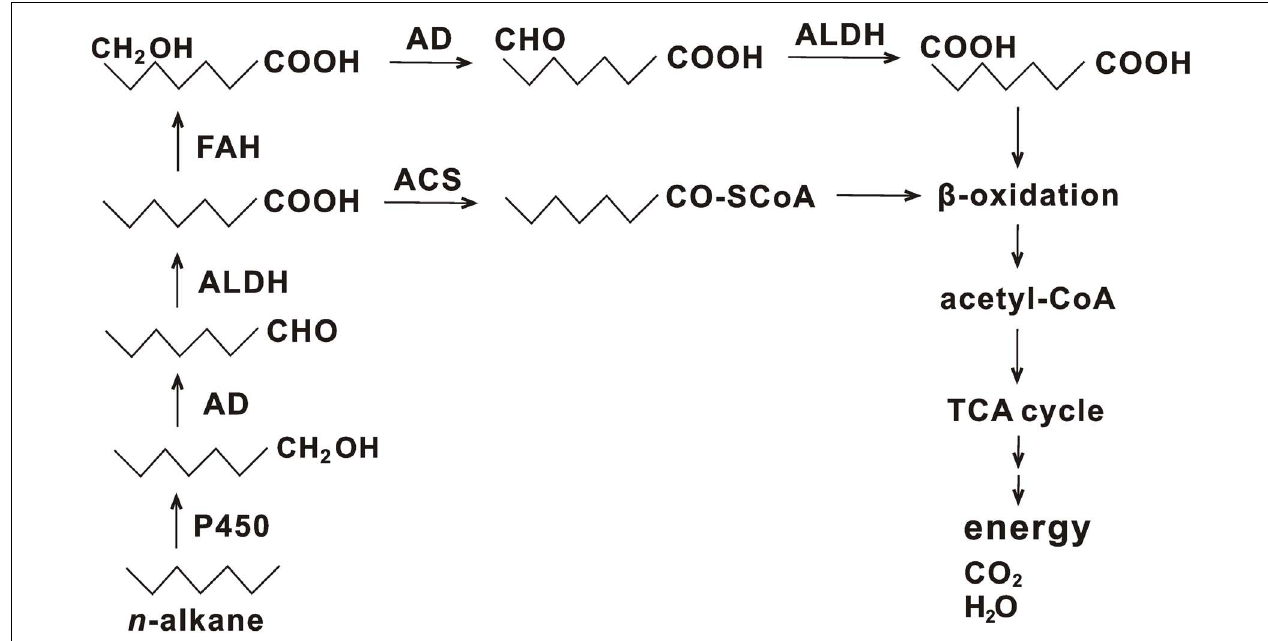
FIGURE 4 | Terminal oxidation pathway for n -alkane degradation in Achromobacter sp. HZ01. P450, cytochrome P450; AD, alcohol dehydrogenase; ALDH, aldehyde dehydrogenase; ACS, acyl-CoA synthetase; FAH, fatty acid hydroxylase; TCA cycle, citrate